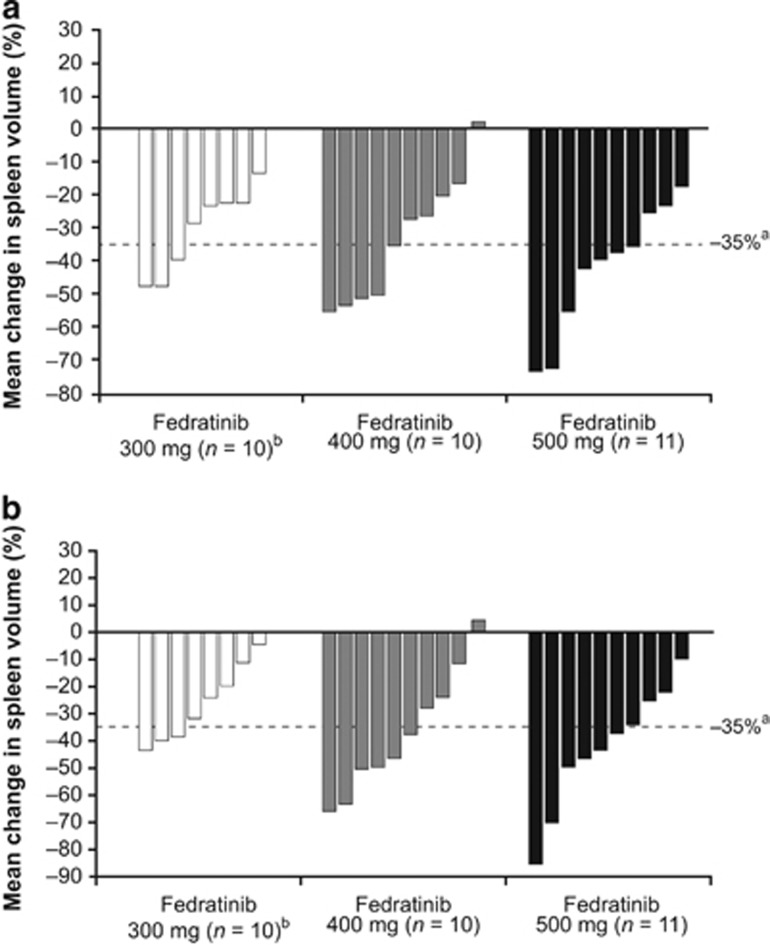
Waterfall plot of changes in spleen volume for individual patients at (a) 12 weeks and (b) 24 weeks. aPatients had a spleen response if they had a ⩾35% reduction in spleen volume from baseline to week 24. bTwo patients discontinued treatment before week 12.